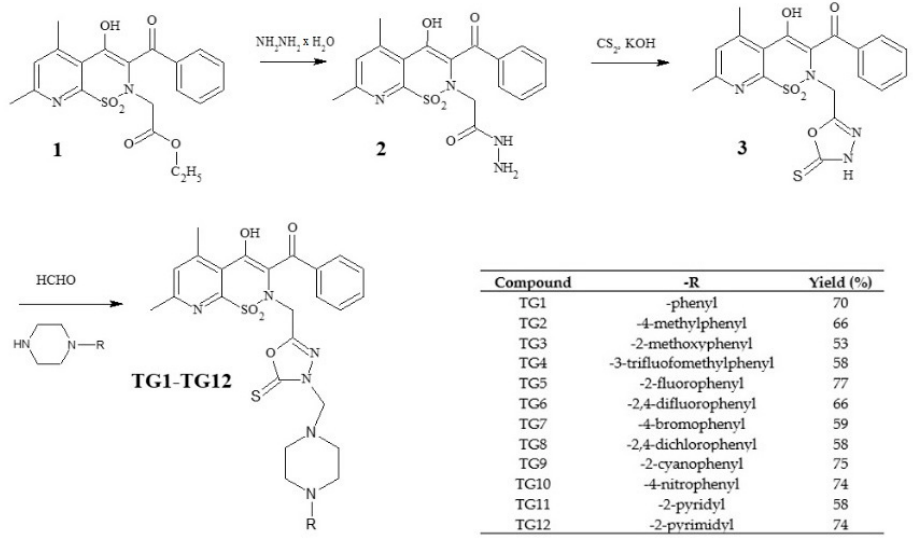
Figure 2. Scheme of the synthesis of new 1,3,4-oxadiazole derivatives of pyridothiazine-1,1-dioxide.